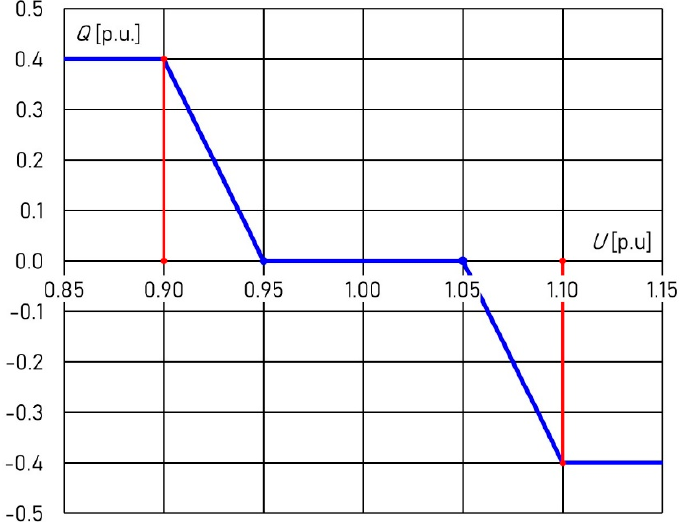
9 of 24 Figure 4. Simplified methods of voltage control in the MV grid with distributed generation: ( a ) tra- ditional regulation—keeping a constant voltage value on the MV busbars, ( b ) keeping a constant voltage value in an optimally selected node deep inside the grid and activating the characteristics of Q(U) inverters. The activation of the characteristics of the Q(U) inverters results in a further improve- ment of voltage conditions in the vicinity of installation of RES units. The required shape